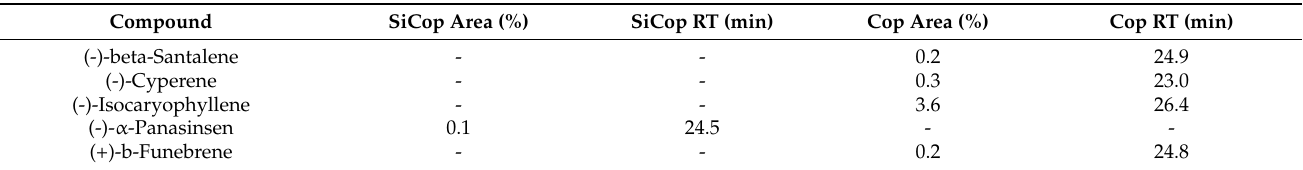
Table 1. Chemical characterization of copaiba oil by gas chromatography with a mass spectrometer detector